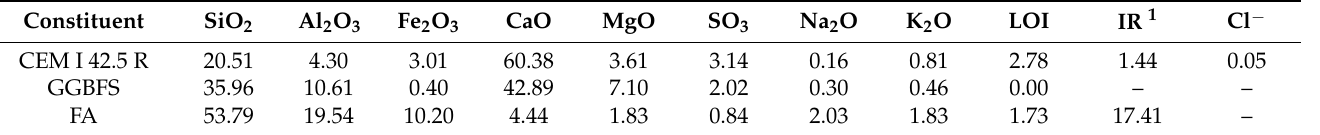
Table 1. Chemical characteristics of the CEM I 42.5 R, GGBFS, and siliceous fly ash, FA